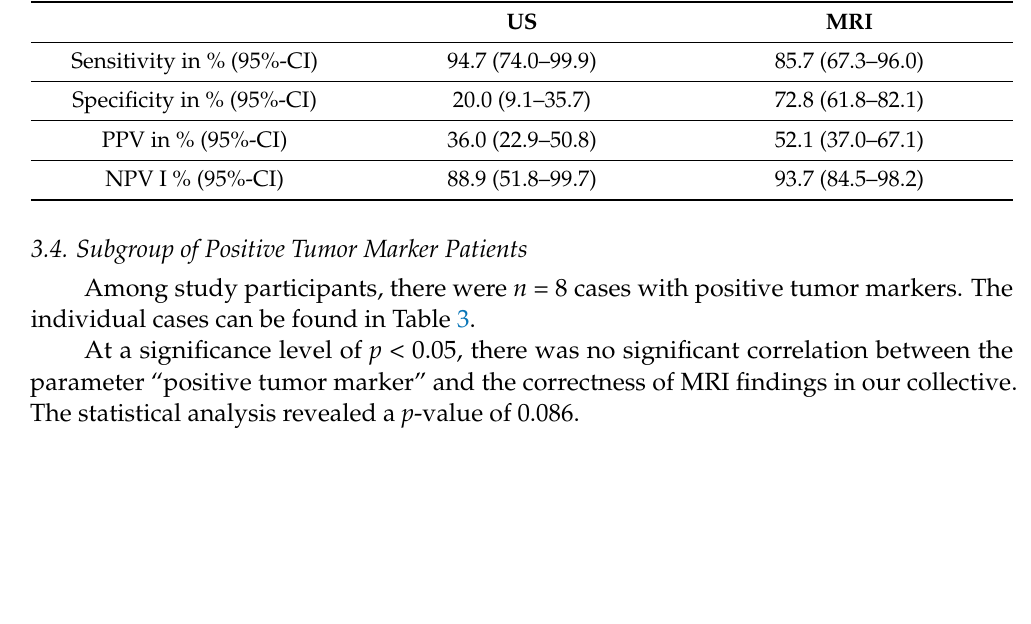
Table 2. Sensitivity, specificity, positive predictive value (PPV) and negative predictive value (NPV) of ultrasound (US) and magnetic resonance imaging (MRI) for the detection of benign and malignant testicular tumors (CI = Confidence Interval). For statistical analysis of MRI data, the category “inde- terminate” was assigned to the opposite gold standard category in the sense of a worst-case